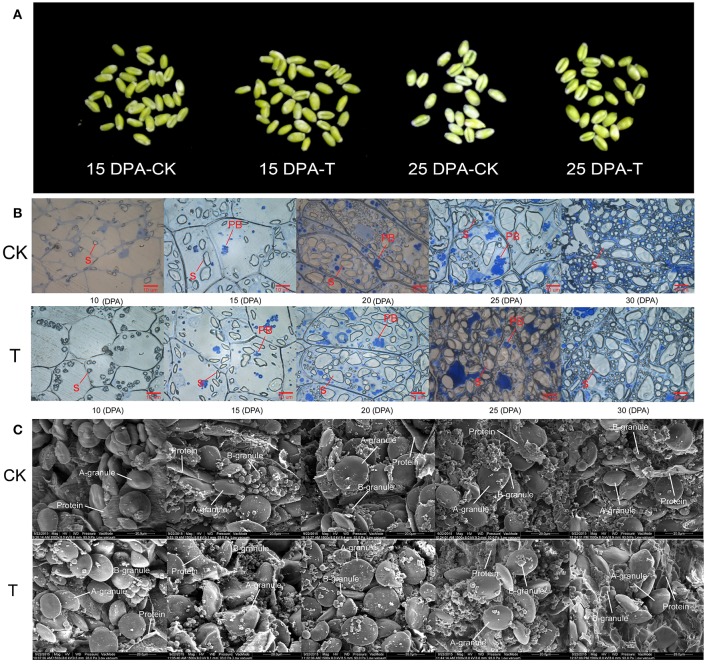
Grain phenotype and microstructure changes under high N treatment (T) and normal N fertilization (CK). (A) Grain appearance at 15 and 25 DPA under different N fertilizer conditions. (B) Light microscope images of developing grains from 5 periods in CK and high N treated groups. The scale bar is 10 μm. The starch and protein body (PB) are marked with lines. (C) SEM images of developing grains from 5 periods in CK and high N treated groups. The scale bar is 20 μm. The A and B starch granules are marked with arrows.